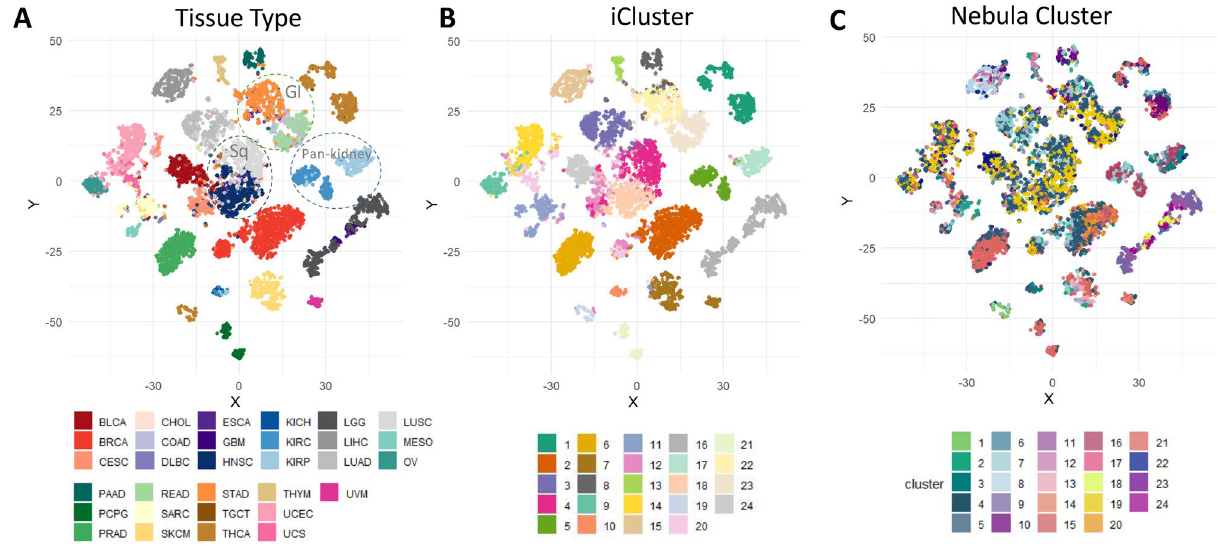
Figure 2. Nebula analysis identifies cancer subtypes driven by shared pathway activities across tissue sites. t-SNE plot of the TCGA 9000 tumor samples across 31 tissue sites. Each dot is a tumor sample. ( A ) Major molecular variation separates organ site where the tumor arise. Circle highlight three broader category including GI (gastrointestinal) track, Sq (squamous cell carcinomas), and Pan-kidney; ( B ) Integrative clustering on